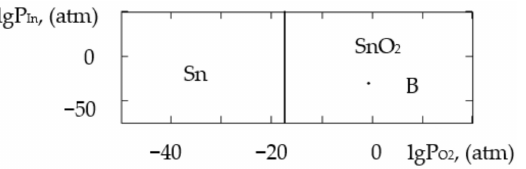
Figure 6. PPD in In–Sn–O system at temperature T = 1073 K within lgP O2 –lgP In .